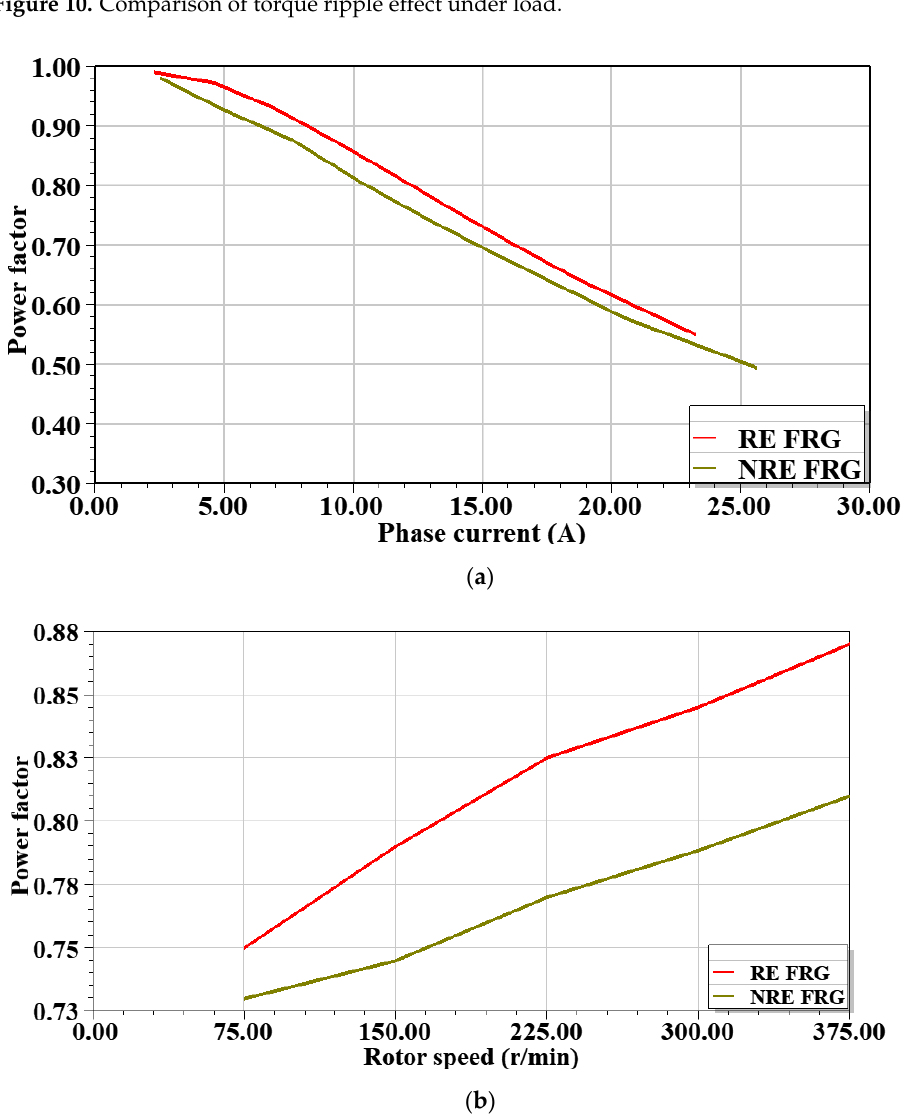
Figure 11 . ( a ) Comparison of phase current against power factor; ( b ) generator speed against power factor at rated load current.